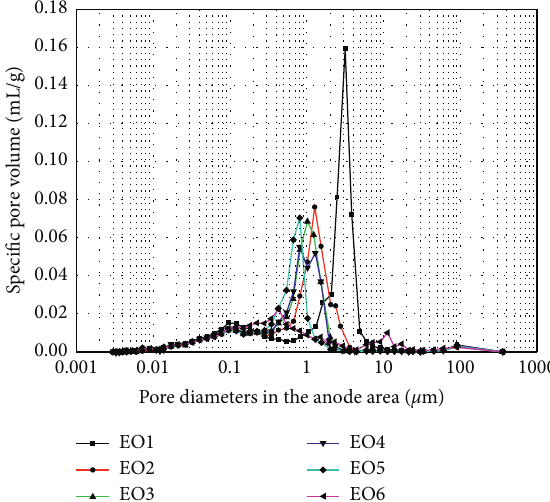
Figure 7: Pore diameters in the anode area.